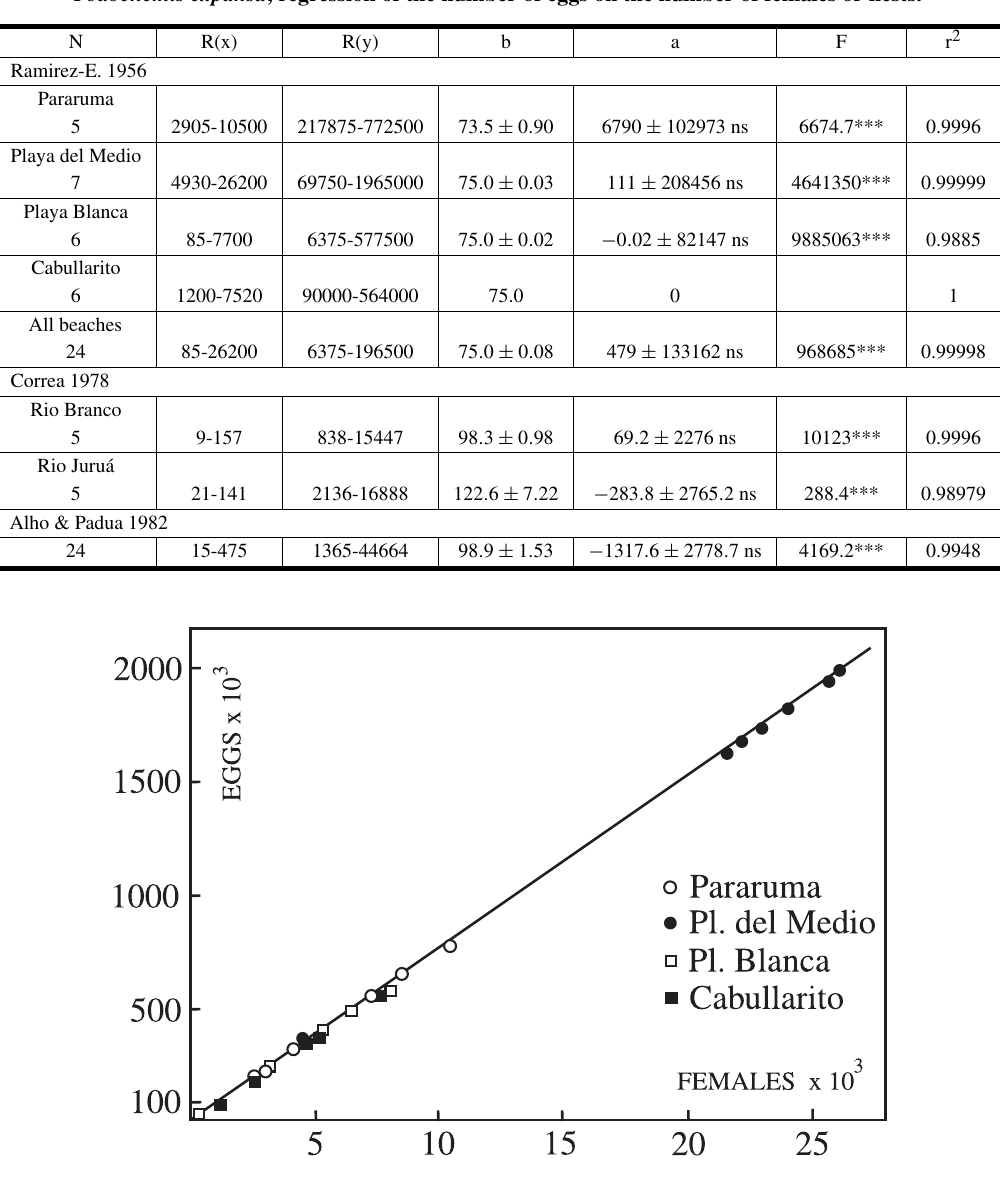
Fig. 1 – Podocnemis expansa . Regression of the number of eggs laid on the number of laying females, beaches on the Rio Orinoco (data from Ramirez-E.